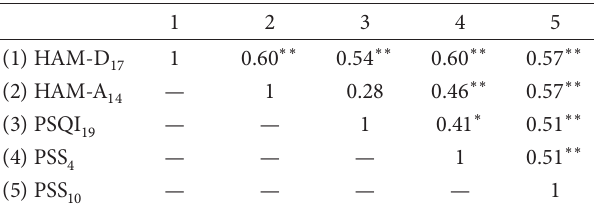
Table 3: Pearson correlation coefficients for selected outcome measures ( 𝑁 = 33